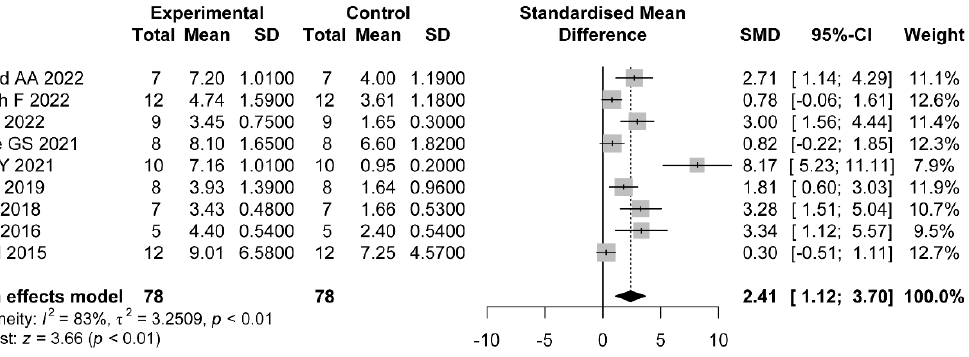
Figure 5. Forest plot of flavonoids for the count of corpus luteum [31,36–39,41,44,46,47].